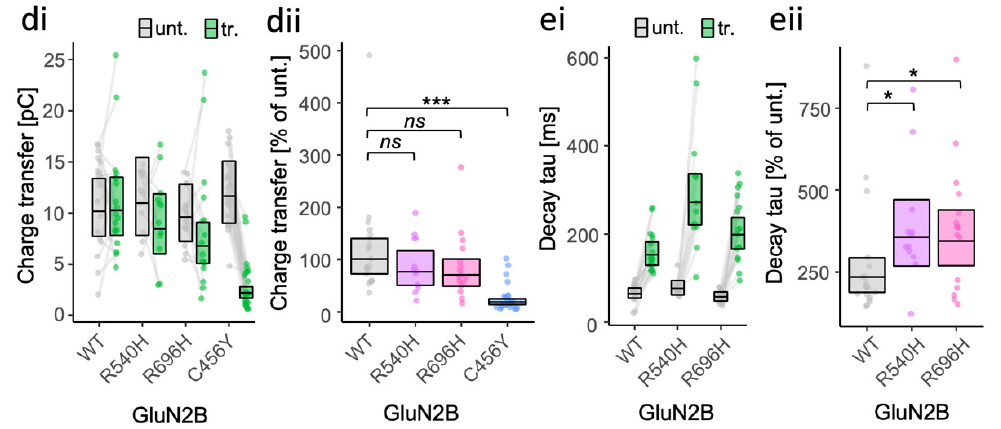
Figure 1. More effective rescue of NMDA-EPSCs in GluN2A/B double knockout neurons by putative GoF mutants (R696H and R540H) than by LoF mutation (C456Y). ( a ) Experimental protocol used to test functional incorporation of GluN2B mutants. Plasmids expressing Cre-GFP and human GRIN2B cDNA were cotransfected into CA1 pyramidal neurons of organotypic hippocampal slices from Grin2a fl / fl b fl/fl mice. With transfection, the action of Cre-GFP at floxed Grin2a and Grin2b alleles knocks out native mouse GluN2A and 2B protein expression concurrently with expressing human GluN2B variants (WT or mutant). Untransfected neurons continue to express native NMDA receptors (e.g., GluN2A and GluN2B). ( b ) Representative NMDA-EPSC +20 mV (average of 30 sweeps) from transfected CA1 neurons. ( c , d ) NMDA-EPSC +20 mV peak amplitudes and charge transfer, respectively, for Grin2a fl/fl b fl/fl (untransfected, abbrv. Unt.) neurons, and Grin2a − / − b − / − neurons rescued with human GluN2B WT, GoF (R540H, R696H) or LoF (C456Y) mutants (transfected, abbrv. Tr.). ( e ) NMDA-EPSC +20 mV decay time constant (tau) and charge transfer, respectively, for Grin2a fl/fl b fl/fl neurons, and Grin2a − / − b − / − neurons rescued with human GluN2B WT, and GoF mutants R540H and R696H; ( c – e ) (i) data points of measurements made in individual neurons; matched data points, for simultaneously recorded untransfected (unt.) and transfected (tr.) neurons, are connected by a line; (ii) response ratios (transfected/untransfected) are expressed as a percentage and plotted for each pair of transfected-untransfected neurons. Crossbars in (i) and (ii) show the estimated marginal means with 95% confidence intervals backtransformed from the linear mixed models (Figure S1.1–1.3 for ( c – e ) respectively). Post hoc pairwise comparisons were made using Dunnett’s stepdown pro- cedure. Standardised effect sizes ( r ) for comparisons of response ratios for: ( cii ) peak amplitudes (vs control: no GRIN2B cDNA, a.k.a. None) were +0.62, +0.39, +0.32 and +0.10 for WT, R540H, R696H, and C456Y, respectively (N = 90); or ( dii ) charge transfer (vs control: WT) was − 0.12, − 0.17 and − 0.68 for R540H, R696H, and C456Y, respectively (N = 71) of ( eii ); decay time constant (tau) was +0.33 and +0.33 for mutants R540H and R696H, respectively (N = 47). Data for the NMDA- EPSC amplitudes in Grin2a − / − b − / − neurons with and without WT GluN2B were published in [40]. ns = not significant (at α = 0.05), * = p < 0.05, ** = p < 0.01, *** = p <